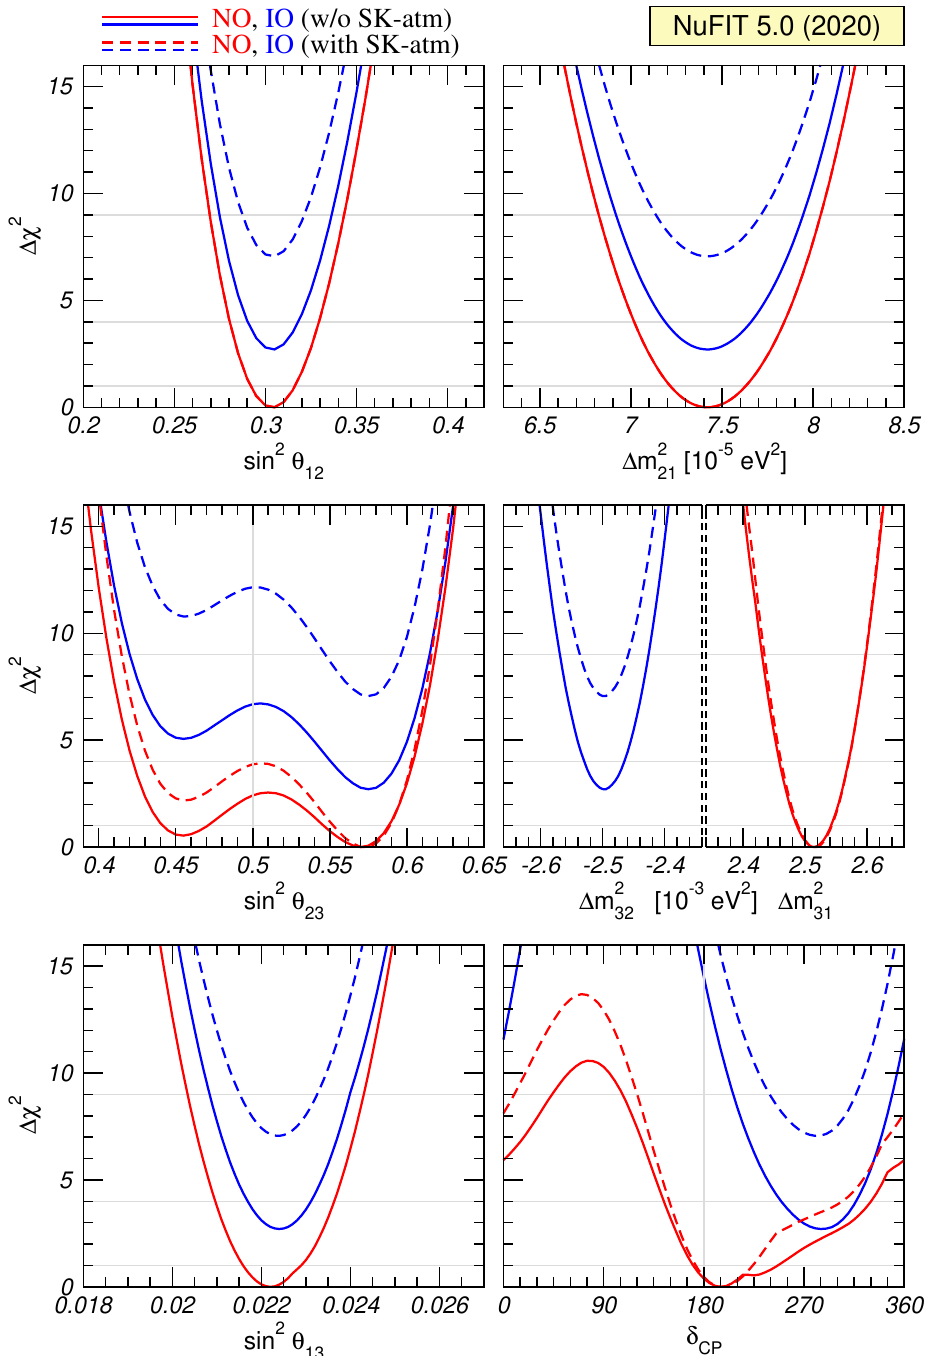
Figure 6 . Global 3 (cid:23) oscillation analysis. We show (cid:1) (cid:31) 2 pro(cid:12)les minimized with respect to all undisplayed parameters. The red (blue) curves correspond to Normal (Inverted) Ordering. Solid (dashed) curves are without (with) adding the tabulated SK-atm (cid:1) (cid:31) 2 . Note that as atmospheric mass-squared splitting we use (cid:1) m 2 for NO and (cid:1) m 2 for IO. 31 32